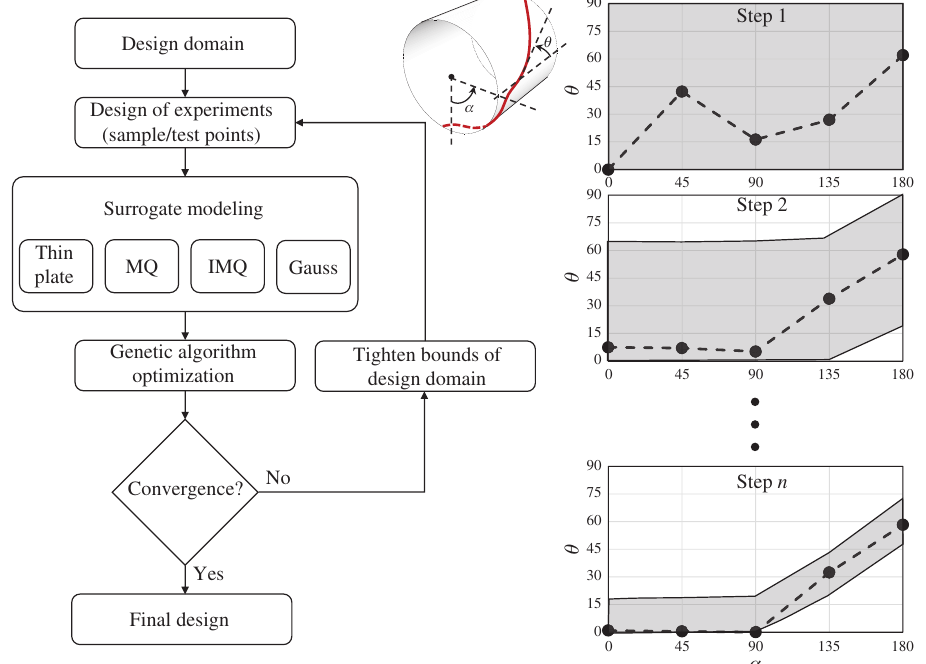
Figure 3: Multi-step design optimization